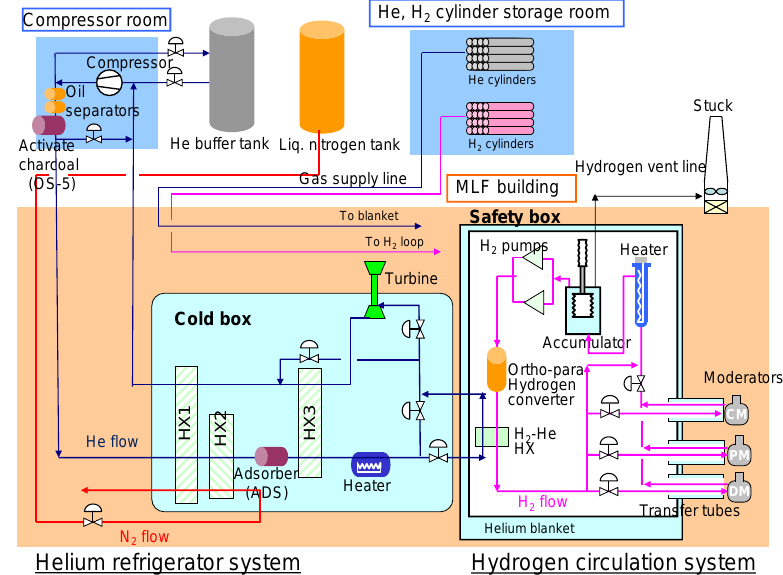
Figure 15. Schematic configuration of the cryogenic hydrogen system employed for pulsed neutron source of the Japan Proton Accelerator Research Complex (J-PARC).